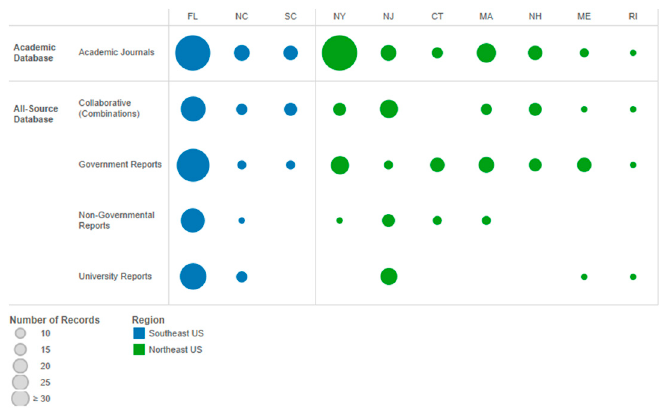
Figure 6. Adaptation literature by document sources across ten southeast and northeast U.S. states.